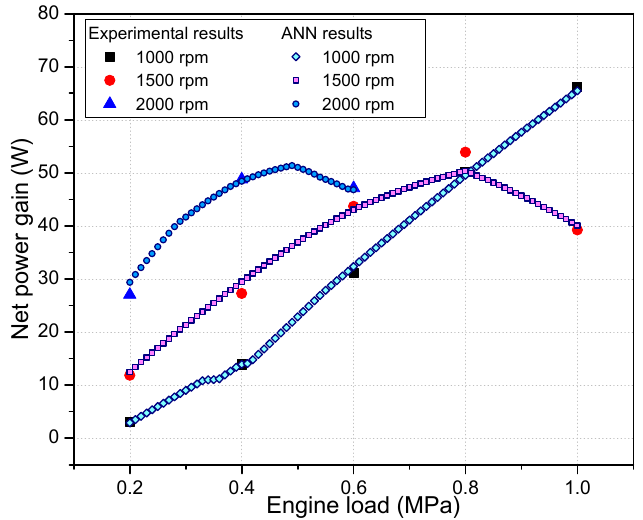
Figure 8. Net power gain of the developed TEG as a function of the engine load and rotation.